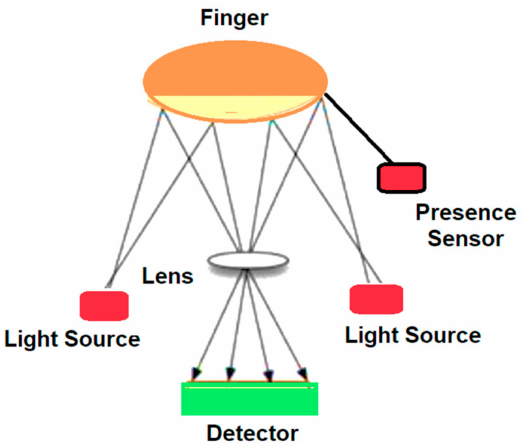
Figure 8. O 2 saturation sensor modified configuration mounted inside the steering wheel of the